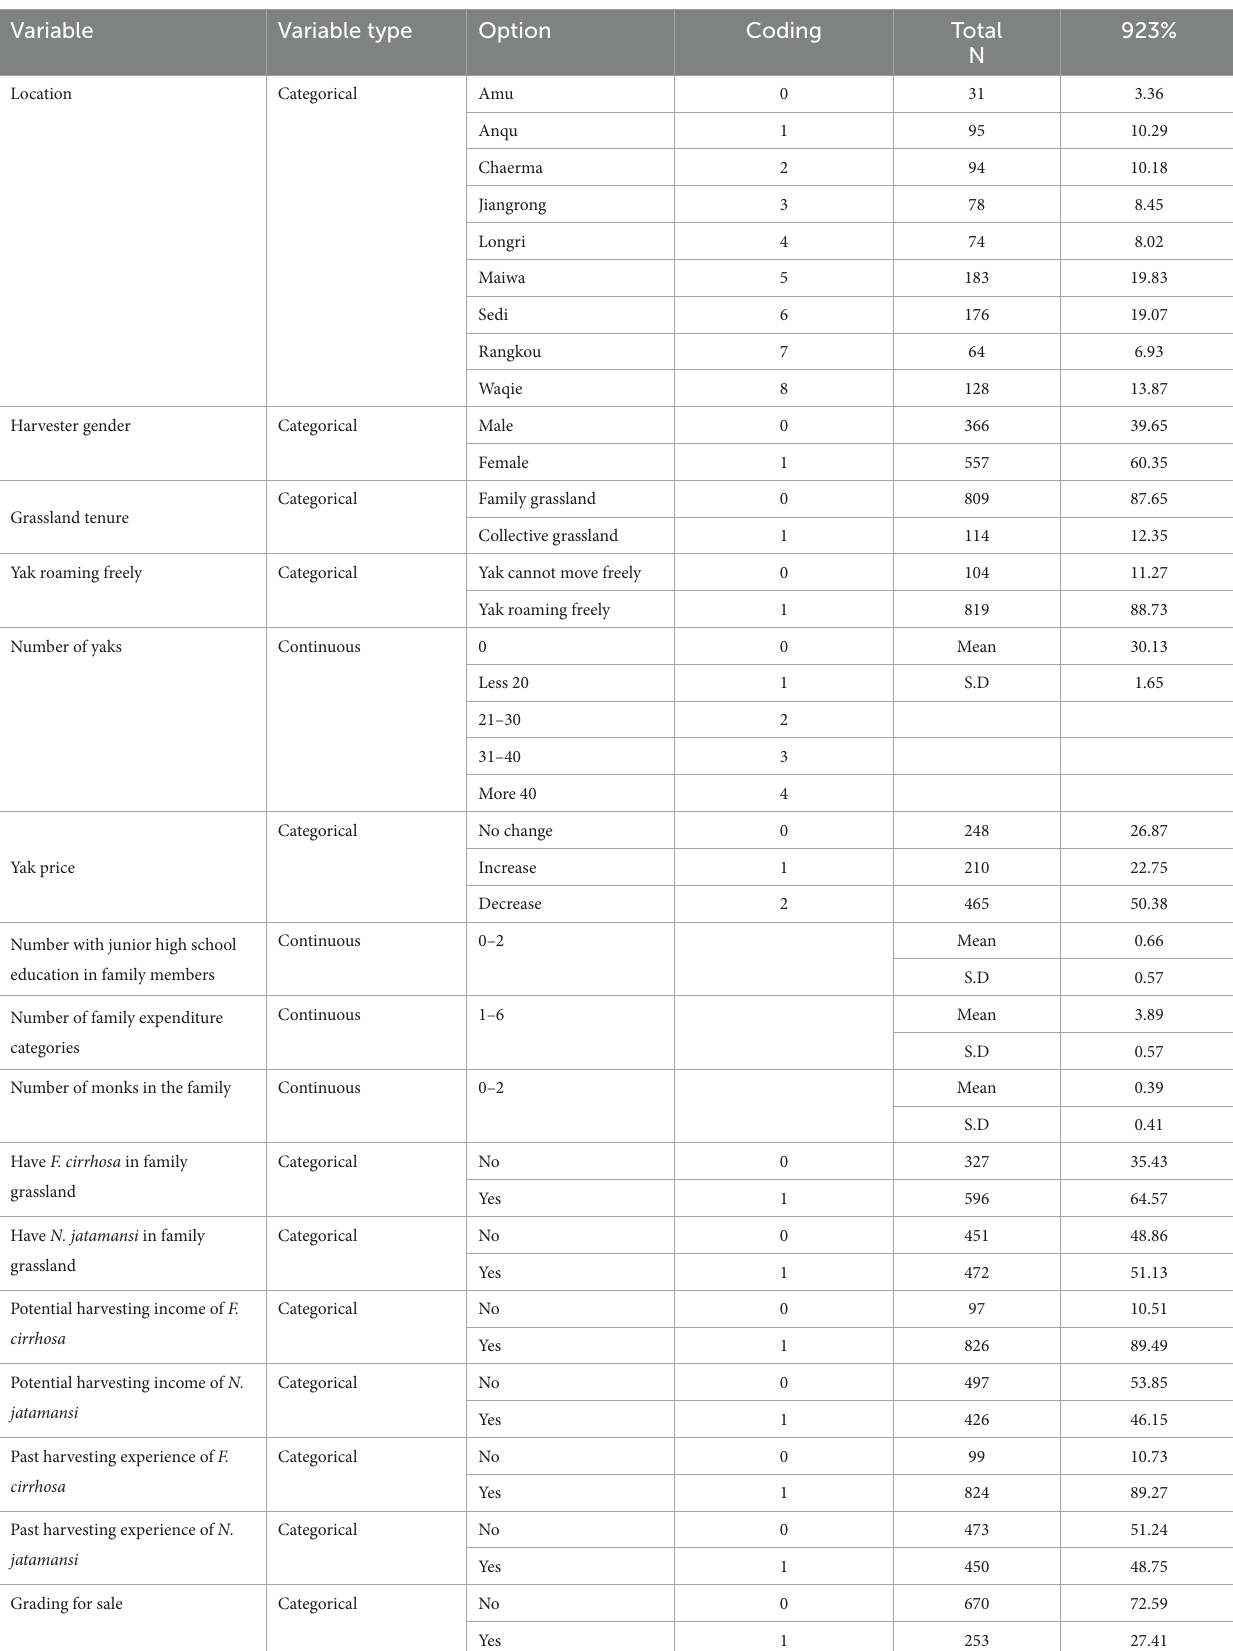
TABLE 2 Sample characteristics of harvesters in Hongyuan